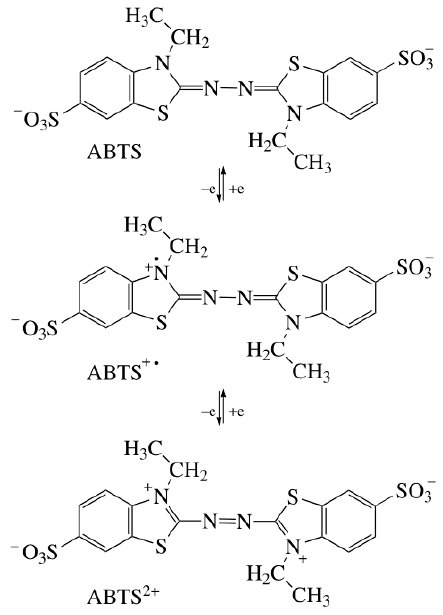
Figure 4. Oxidation of ABTS by Laccase.